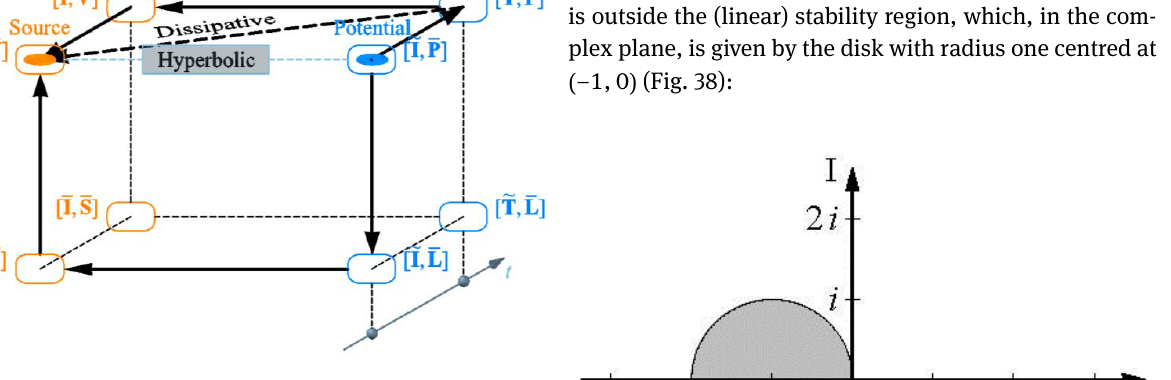
Figure 37: Hyperbolic equations in the classification diagram.